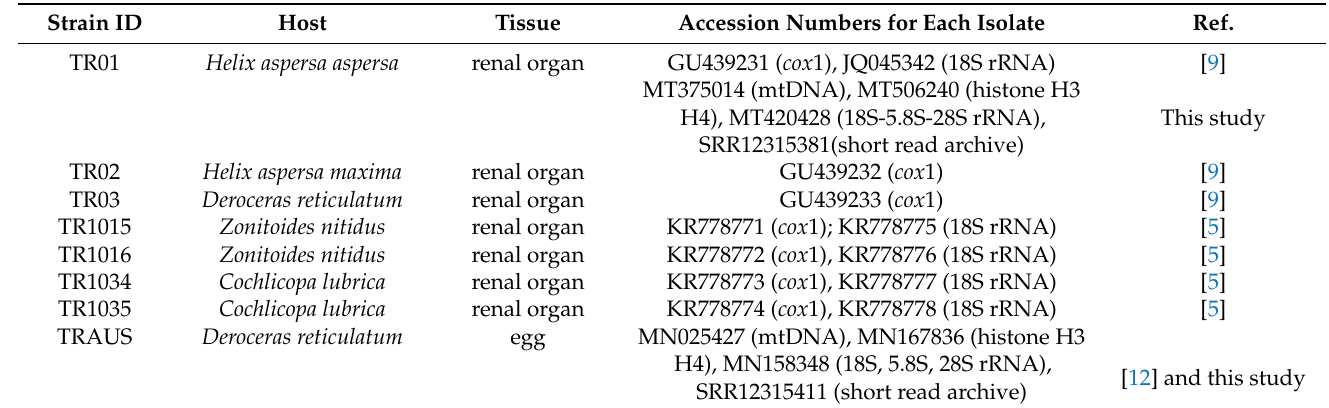
Table 1. Tetrahymena rostrata isolates and